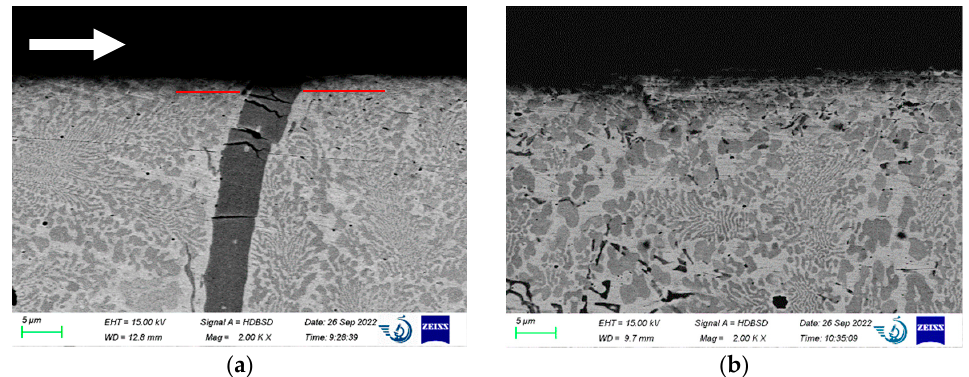
Figure 9. The microstructure (cross-section) of the alloy below the friction surface, 15 MPa. The arrow indicates the friction direction for both images: the bent and cracked boride grain ( a ) and uniform microstructure without coarse borides ( b ). White arrow shows the friction direction for both micrographs.